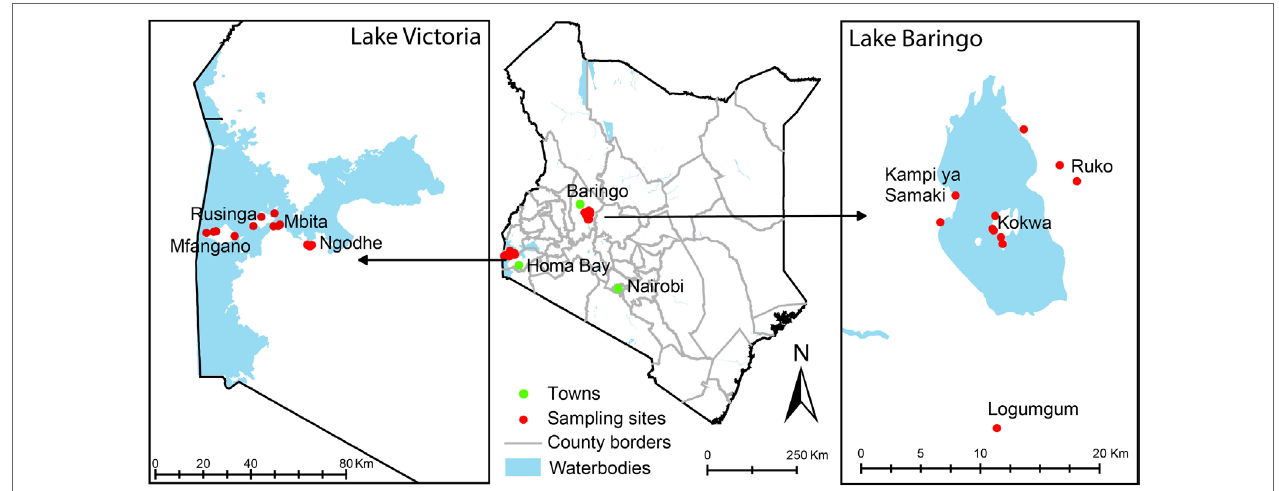
FigUre 1 | Map of Kenya showing tick sampling areas in Kenya . Most of the sampling points were in rural villages where mosquito sampling has previously been